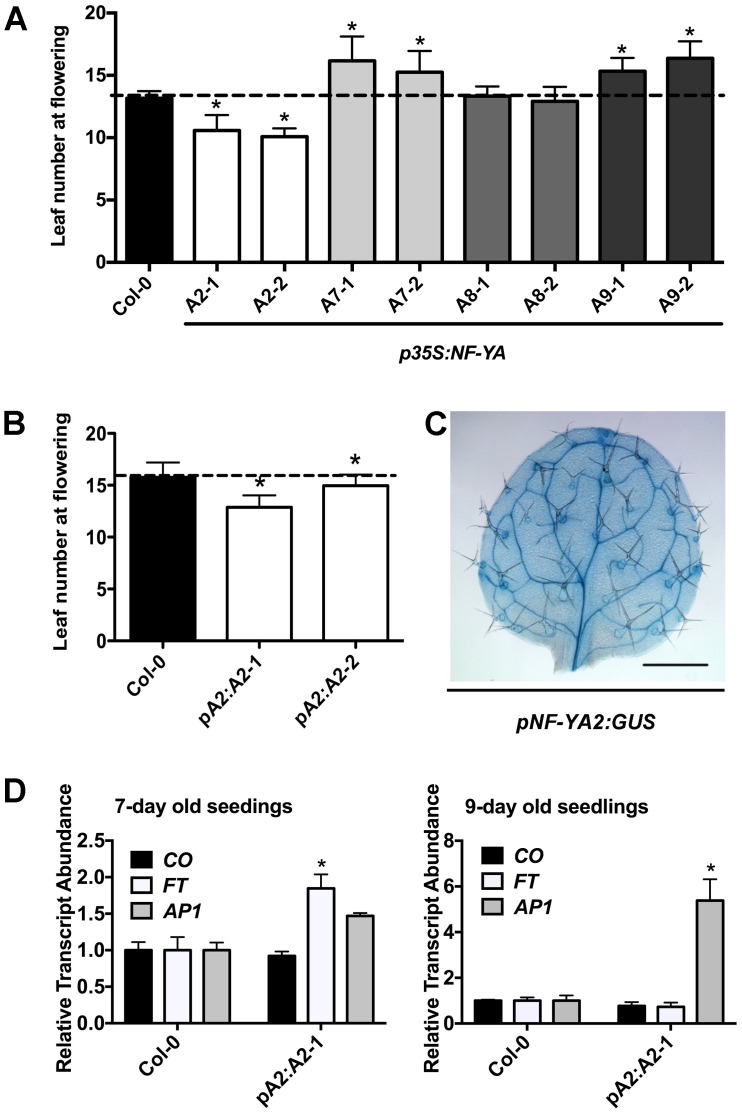
NF-YA2 is a positive regulator of photoperiod dependent flowering.A) Flowering time quantification of two independent plant lines each (plant lines 1 and 2) for p35S:NF-YA2 (white bars), p35S:NF-YA7 (light grey bars), p35S:NF-YA8 (grey bars), and p35S:NF-YA9 (dark grey bars) (n≥12/line). B) Flowering time quantification of two independent pNF-YA2:NF-YA2 plant lines (n≥24). C) The expression pattern of pNF-YA2:GUS in leaves of 10 day old plants. D) Relative transcript abundance of CO, FT, and AP1. Asterisks in 1A and 1B represent significant differences derived from one-way ANOVA (P < 0.05) followed by Dunnett’s multiple comparison post hoc tests against Col-0. Asterisks in 1D represent significant differences derived from Student’s T-tests (P < 0.05). All experiments were repeated with identical results.